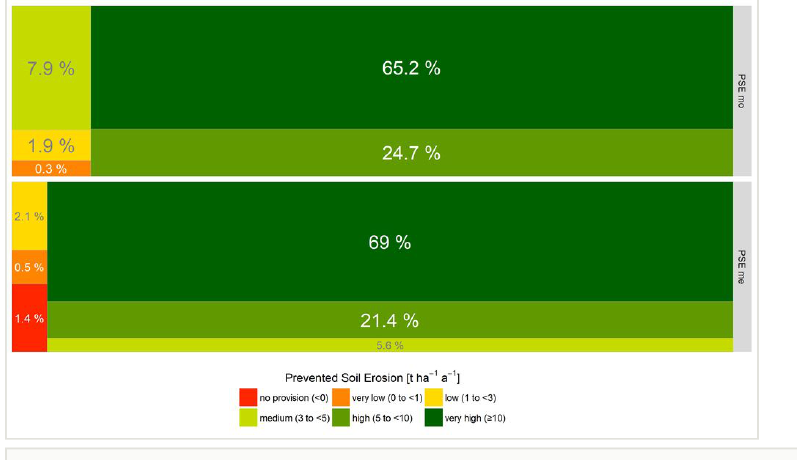
Area proportions of the soil erosion indicators describing the prevented soil erosion (PSE : based on modelled actual soil loss data: based on measured actual soil loss data: PSE ). The treemaps visualise the proportions of soil loss classes for the whole investigation